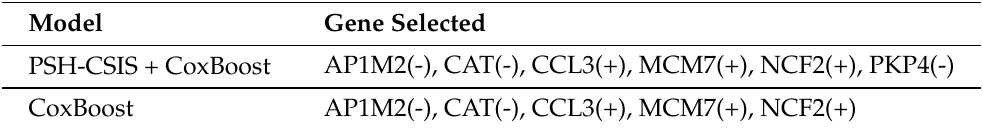
Table 2. Genes selected by the two competing models. A risk gene with a positive coefficient from the fitted model is denoted by “+”, while a protective gene with a negative coefficient is denoted by “-”.